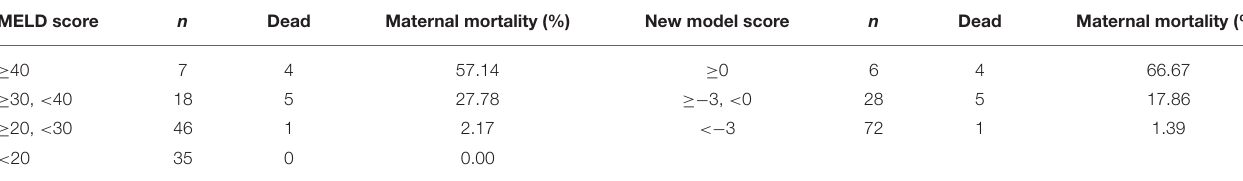
TABLE 8 | Relationship between MELD score and the new model for maternal mortality. MELD score n Dead Maternal mortality (%) New model score